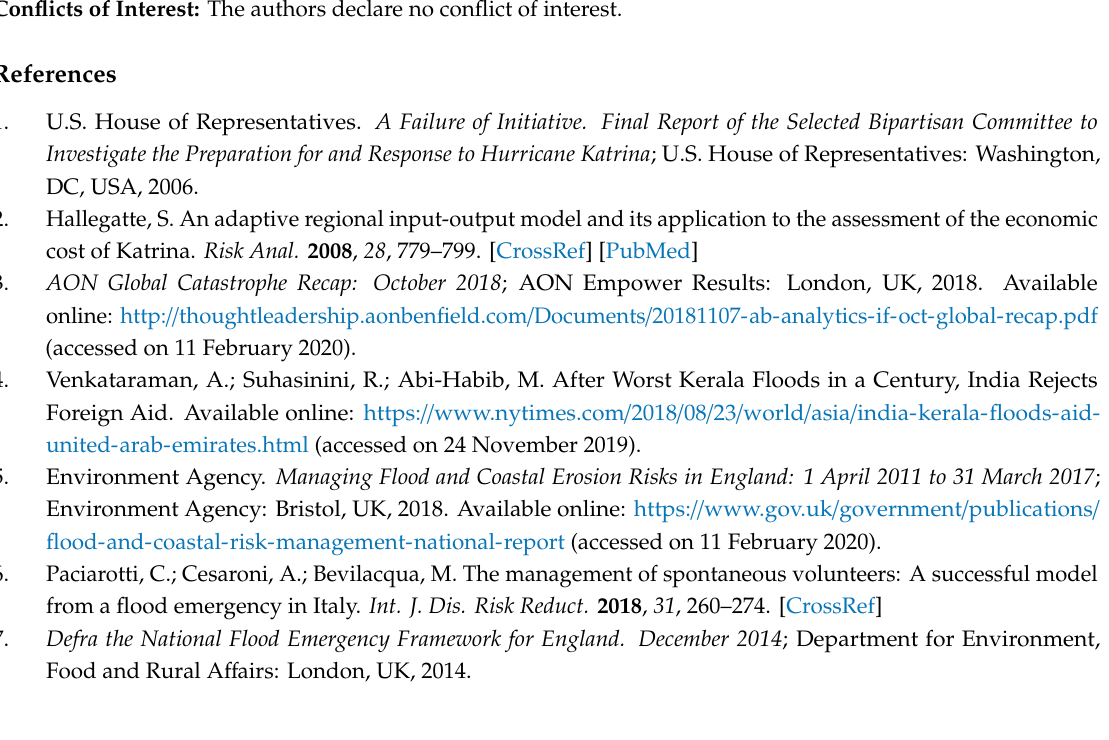
Table S1: Organisations involved in the flood emergency response in England and India and their associated